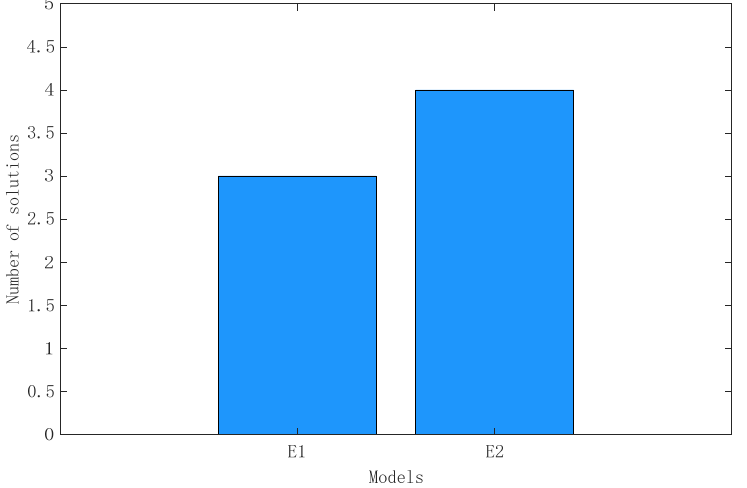
Figure 14. The number of model optimization solutions obtained for each model.